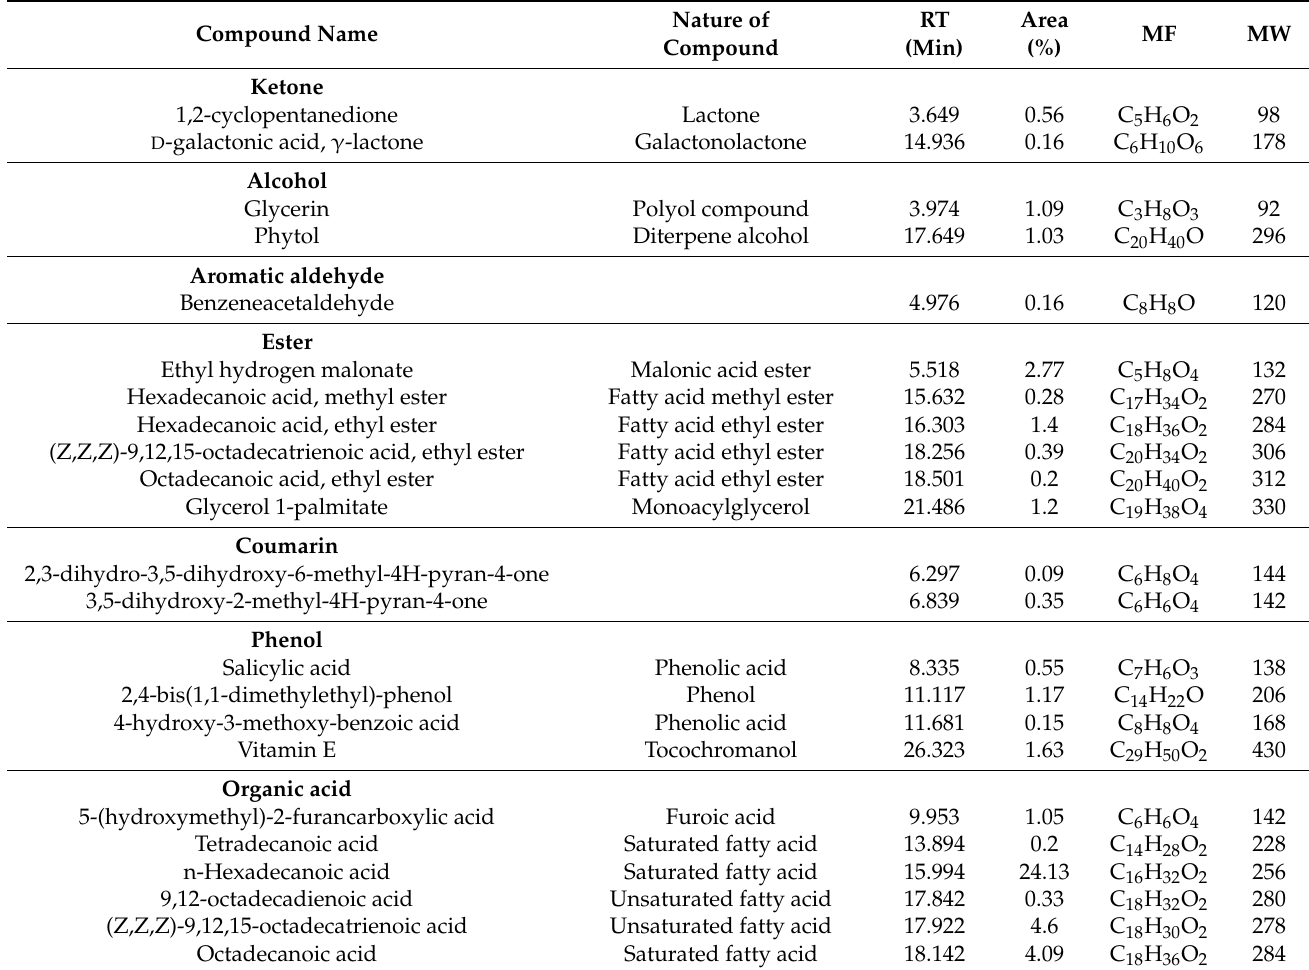
Table 1. Metabolite profiling in Momordica charantia L. (MC) obtained by GC-MS/MS analysis.